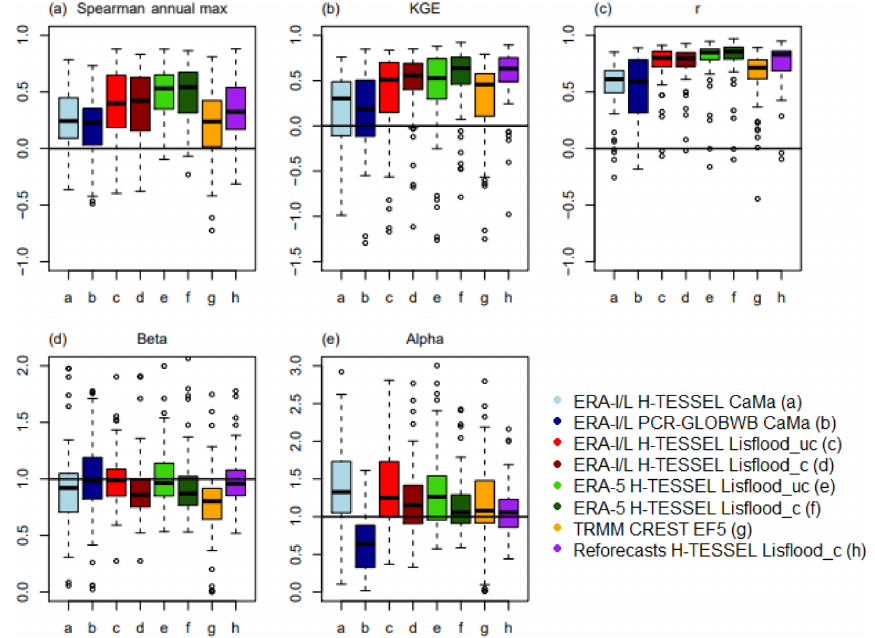
Figure 7. Boxplots showing the distribution of scores for the (a) Spearman annual maximum correlation, (b) KGE, (c) KGE Pearson’s coefficient, (d) KGE beta, and (e) KGE alpha, for all simulations. For the period 1997–2015.